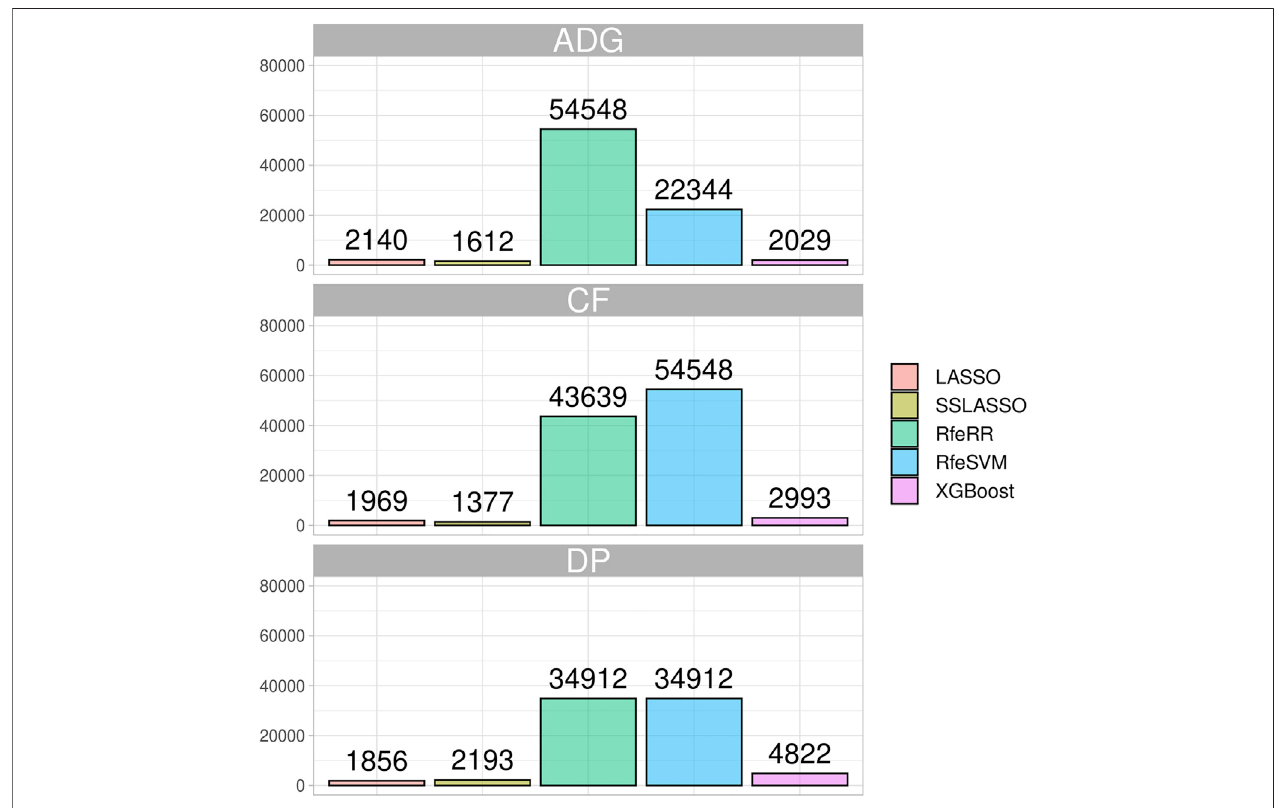
FIGURE 5 | Bar plot representing the number of SNPs retained by each algorithm on the three phenotypes of the Rendena population.